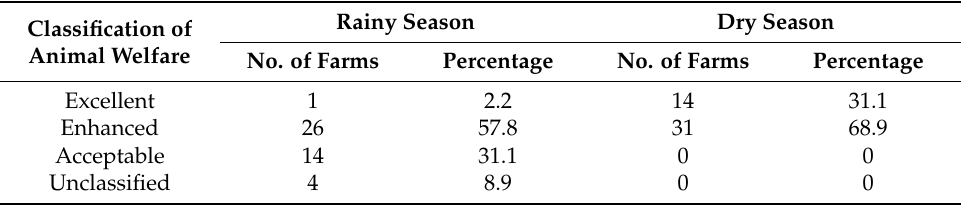
Table 2. Number and percentage of farms according to their final classification of assessment with the Welfare Quality protocol. n =